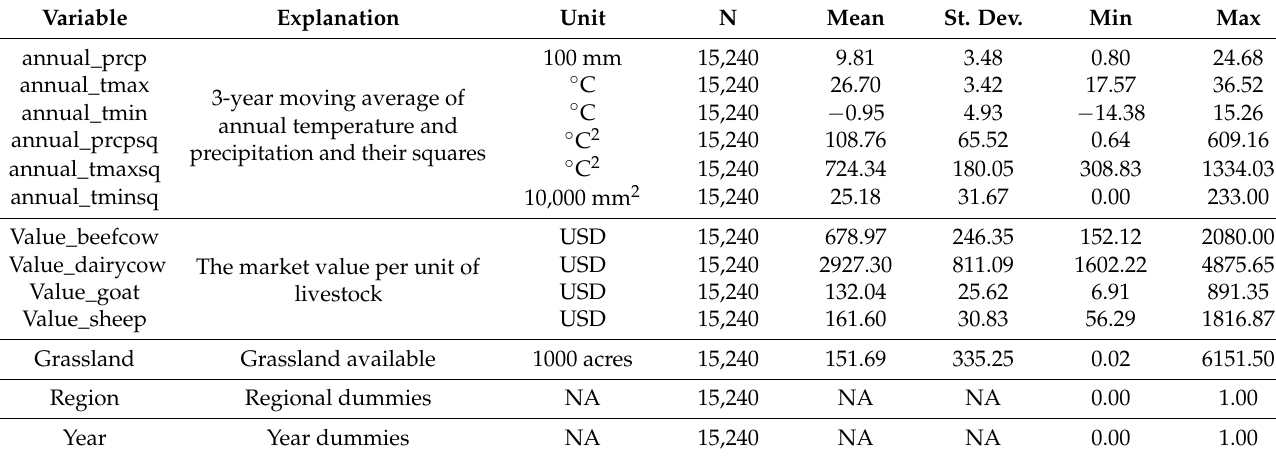
Table 4. Descriptive statistics.